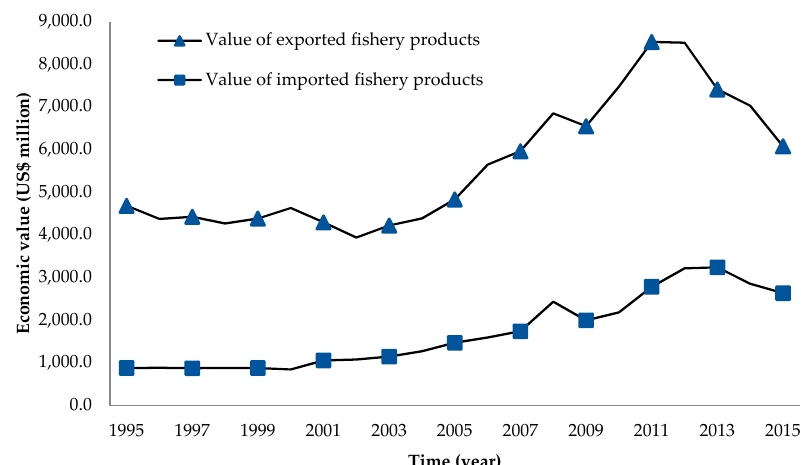
Figure 2. Quantity and value of exported and imported fishery products from 1995 to 2015. Based on data from the DoF [21].